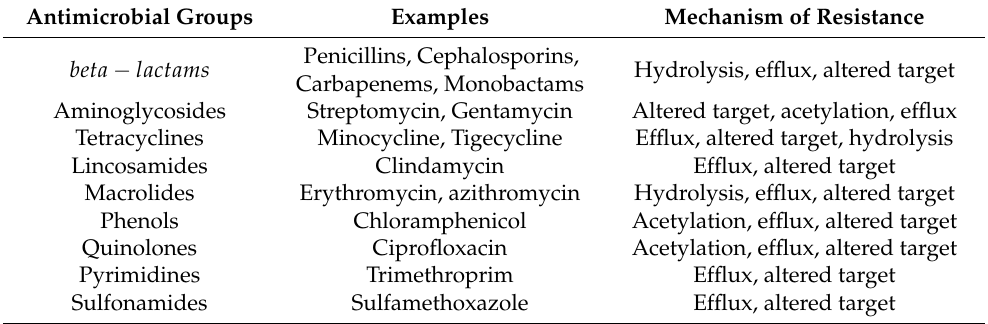
Figure 4. General mechanisms of antimicrobial resistance [62]. Table 3. The mechanisms of resistance of some common antibiotics [63]. Antimicrobial